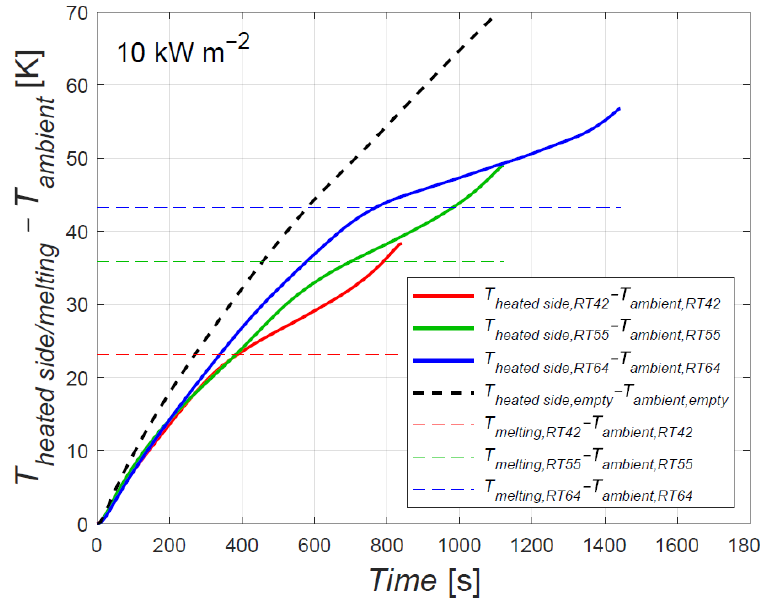
Figure 8. Temperature difference profiles at 10 kW − 2 for different paraffins. Table 3. Summary of the experimental results.